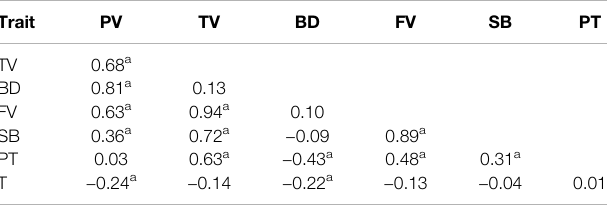
TABLE 1 | Pearson ’ s correlation coef fi cients (r) between RVA